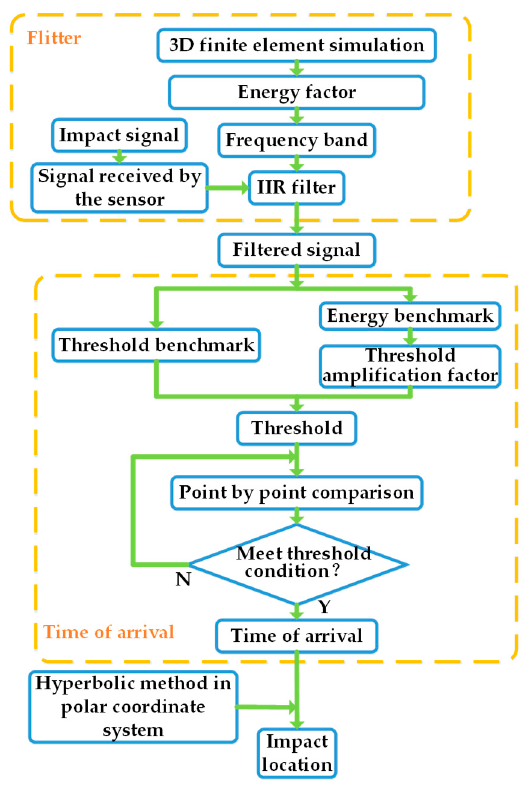
Figure 1. Flow chart of the adaptive energy compensation threshold filtering (AECTF) method.